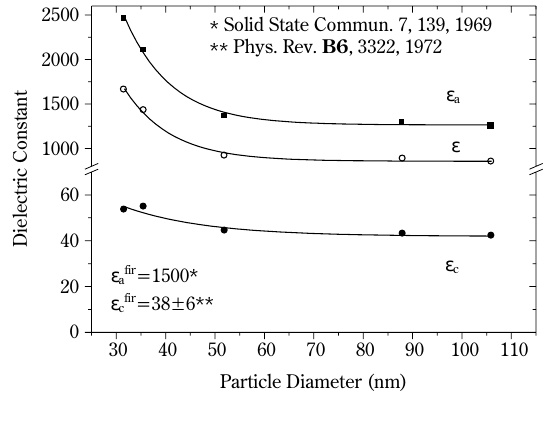
Change in the intrinsic dielectric constant for BT nano- crystals estimated by raman scattering with particle